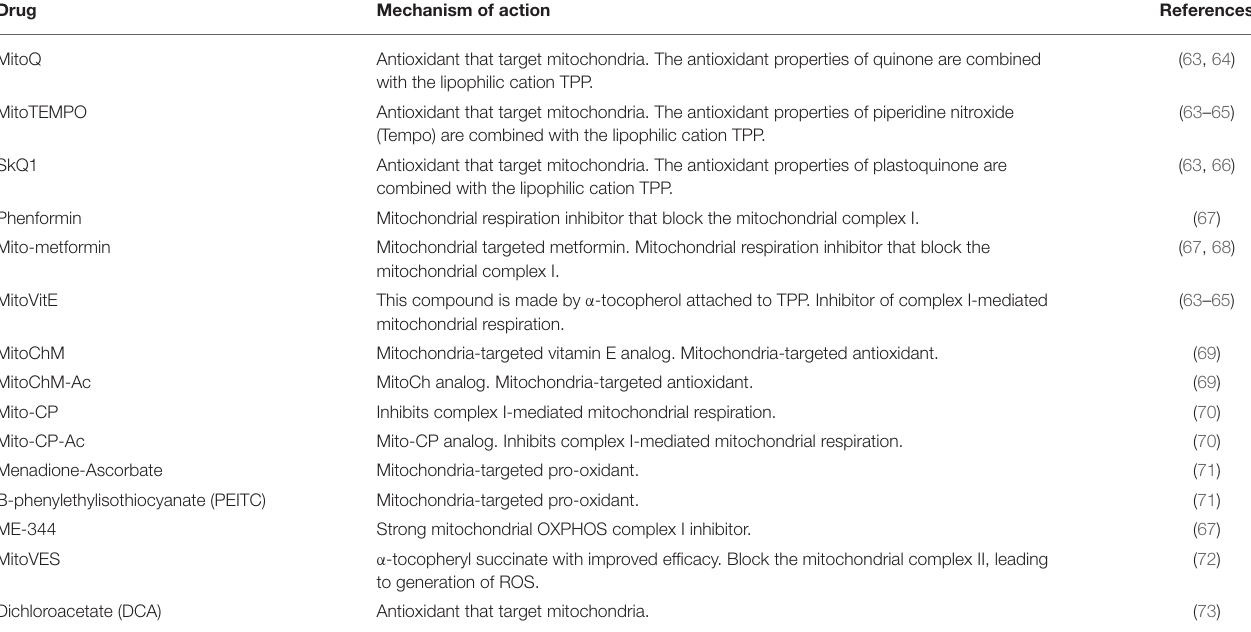
TABLE 1 | Drugs targeting mitochondrial redox capacity. Drug Mechanism of